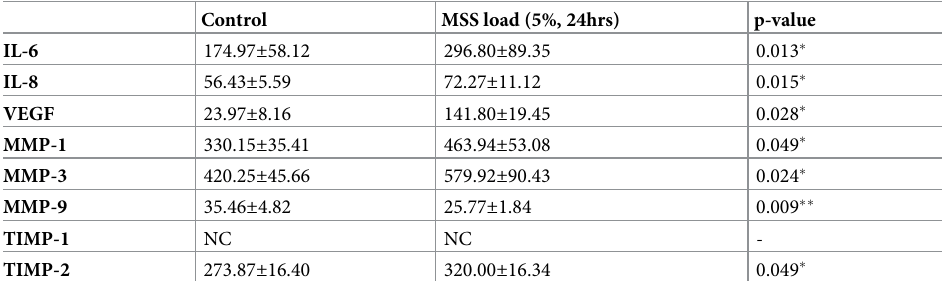
TIMP-1 NC NC - TIMP-2 273.87 ± 16.40 320.00 ± 16.34 0.049 � ECM, extracellularmatrix; LF,ligamentum flavum; IL, interleukin; VEGF, vascular endothelial growth factor; MMP, matrix metalloproteinases; TIMP, tissue inhibitors of metalloproteinase; NC, Not Competent Values unit; ng/mL. ± SE � P < 0.05, significant increase in concentration. �� P < 0.05, significant decrease in